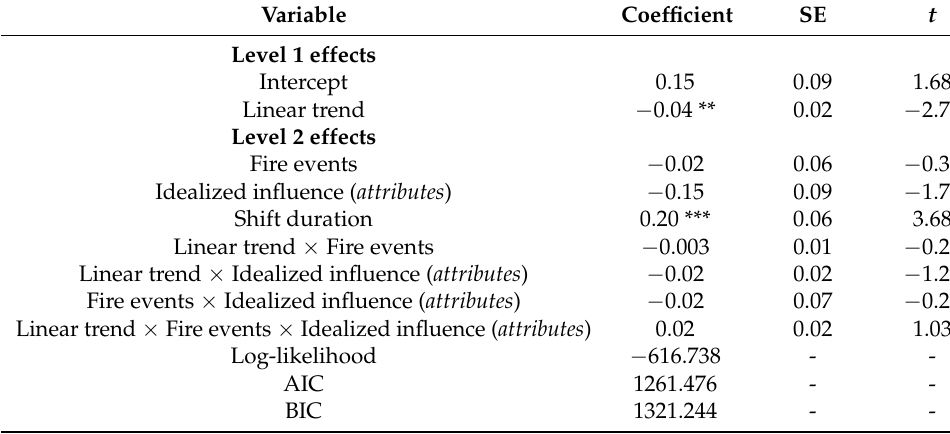
Table A7. Fire Events and Idealized Influence (Attributes) Predicting Change in Emotional